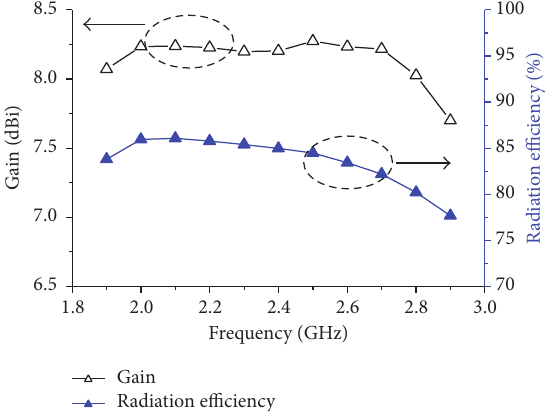
Figure 14: Measured gain and radiation efficiency of the proposed antenna. Table 2: Comparisons of various dual-polarized antennas.